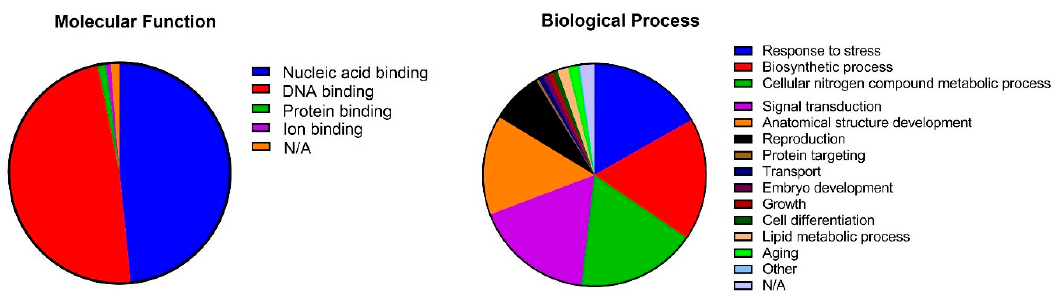
Figure 5. Molecular functions and biological processes of members of the TtAP2/ERF family based on gene ontology (GO) analysis.